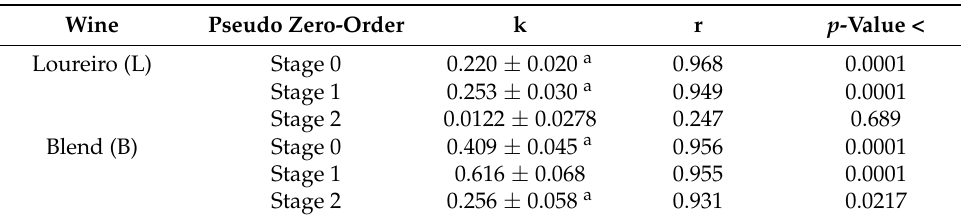
Table 4. Kinetic model for b * (yellowness) of the Loureiro monovarietal wine and Blend wine before and after